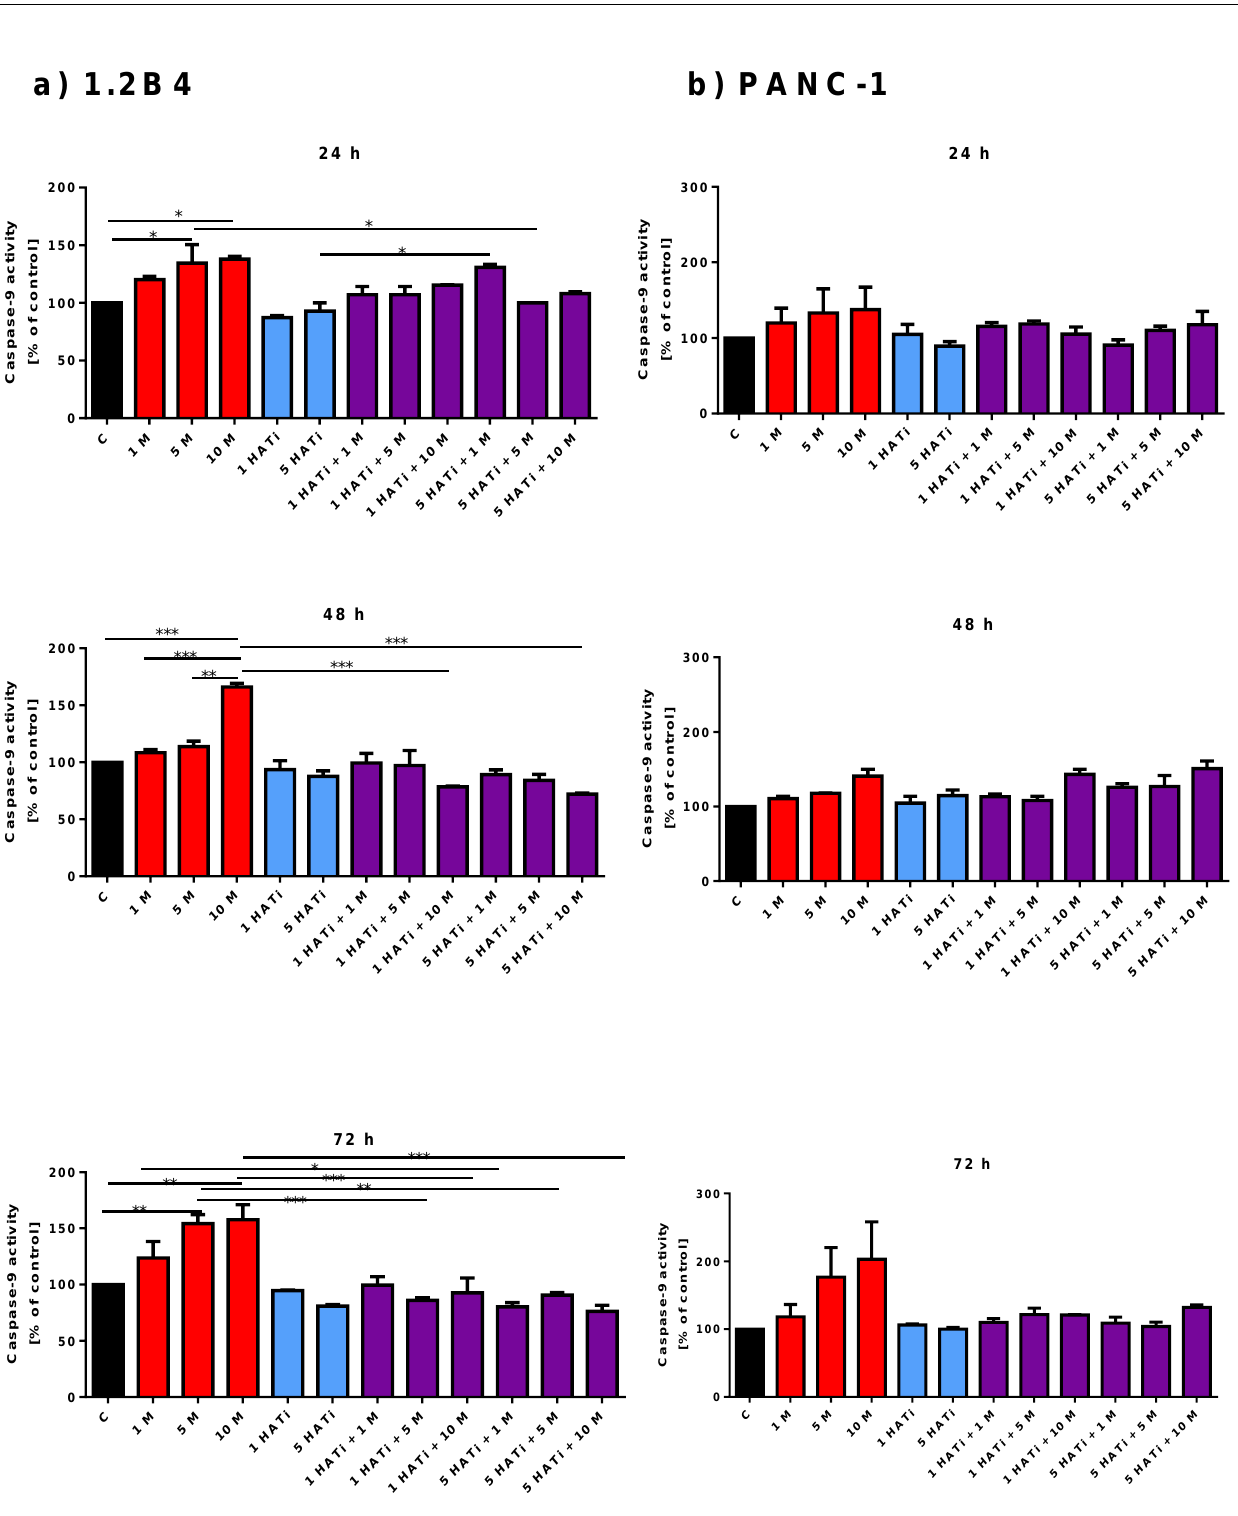
Figure 3. The effect of metformin, HATi, and combination of HATi with metformin on the activity of caspase-9 in 1.2B4 ( a ) and PANC-1 ( b ) cells. Activity of caspase-9 in 1.2B4 ( a ) and PANC-1 ( b ) cells was determined by Caspase-9 Colorimetric Activity Assay Kit. The cells were treated with metformin (1, 5, and 10 mM; red bars), HATi (1 and 5 µM; blue bars), and combination of HATi (1 and 5 µM) with metformin (1, 5, and 10 mM; violet bars) for 24, 48, and 72 h. Data are expressed as the mean ± SD. * p < 0.05, ** p < 0.01, and *** p < 0.001.